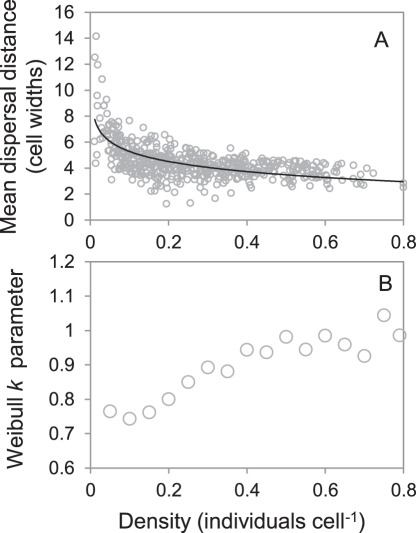
Results of simulations with promiscuous mating and no territory defense.These figures show the relationship between density and (A) mean annual linear dispersal distances, and (B) Weibull function shape parameter (k) values derived from binned annual dispersal distances from 1,000 years of model runs (bin size 0.005 individuals cell−1). When k = 1, the distribution conforms to a negative exponential function as expected under random walk diffusion. A value k<1 indicates increasing leptokurtosis in dispersal distances, and hence a more fat-tailed distribution.